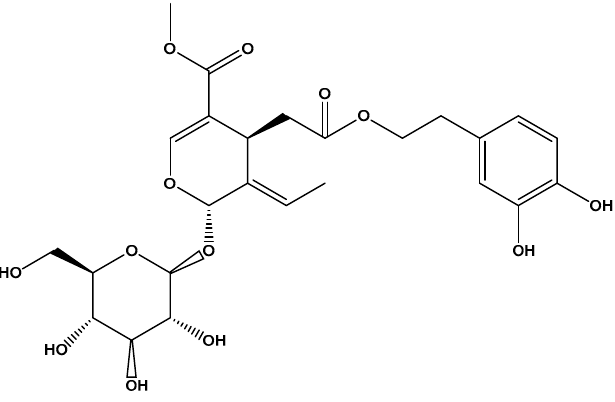
Figure 3. The structure of oleuropein.